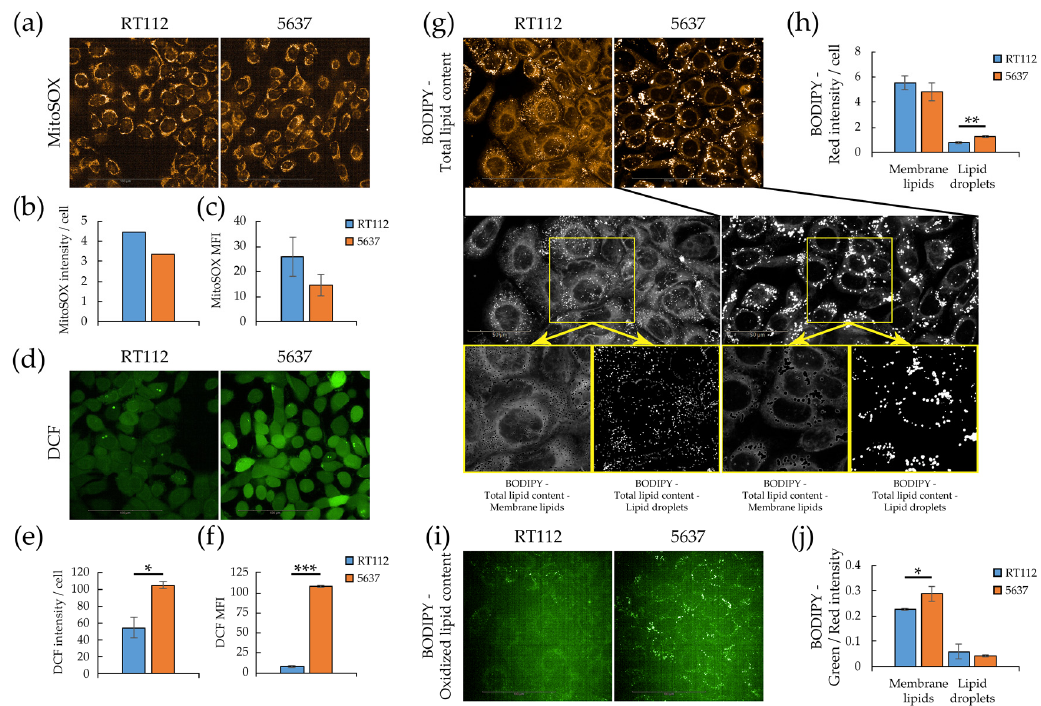
Figure 5. Redox homeostasis and lipid peroxidation in RT112 and 5637 cells. Quantitative imaging was performed with Operetta CLS™ and Harmony software ( a ) Confocal imaging of living cells stained with MitoSOX (orange). ( b ) Mitochondrial ROS level per cell calculated as the ratio of